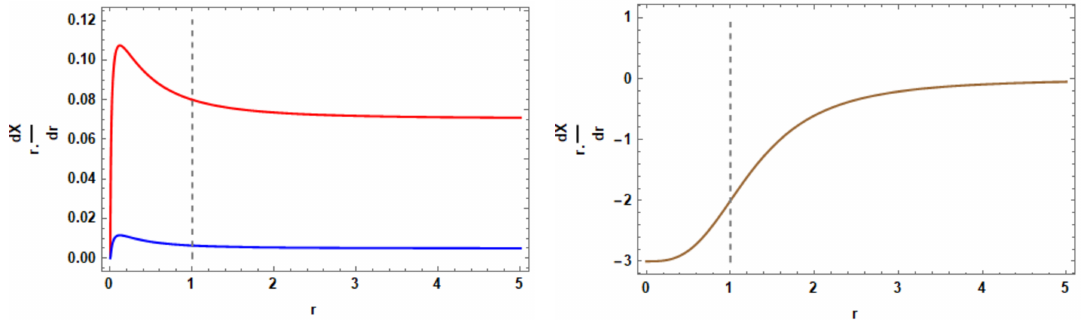
Figure 2. Another flow from UV AdS to Kasner universe. This corresponds to a deformation parameter A 1 = 49 . 88 . For the left figure from top to bottom X are respectively φ ( r ) and χ ( r ) . For T the right figure X = log g 0 ( r ) . In the both figures dotted vertical line represents the position of tt horizon, r H